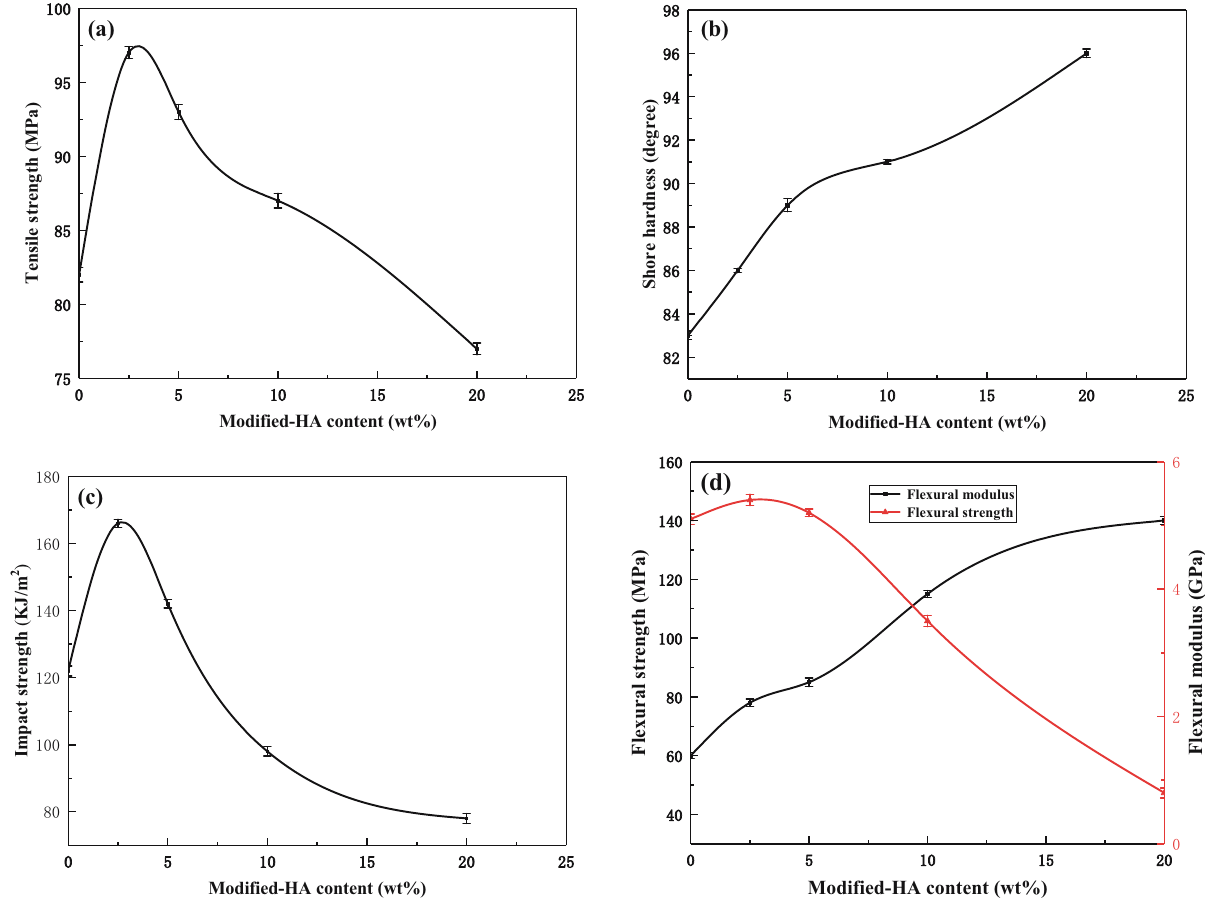
Figure 5: E ff ect of modi fi ed - HA content on the mechanical properties of HA/PEEK nanocomposites: tensile strength ( a ) , shore hardness ( b ) , impact strength ( c ) , and fl exural strength and modulus ( d ) .